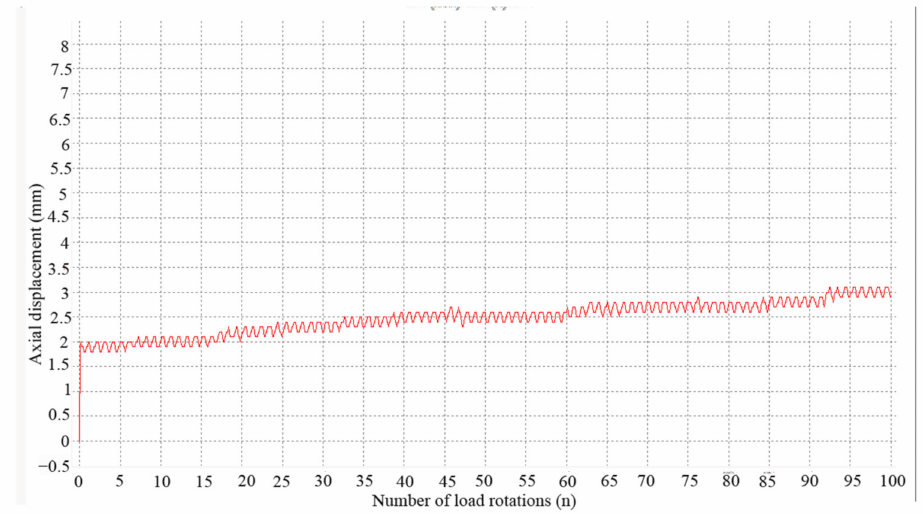
Figure 8. Real-time displacement under cyclic rotating axial